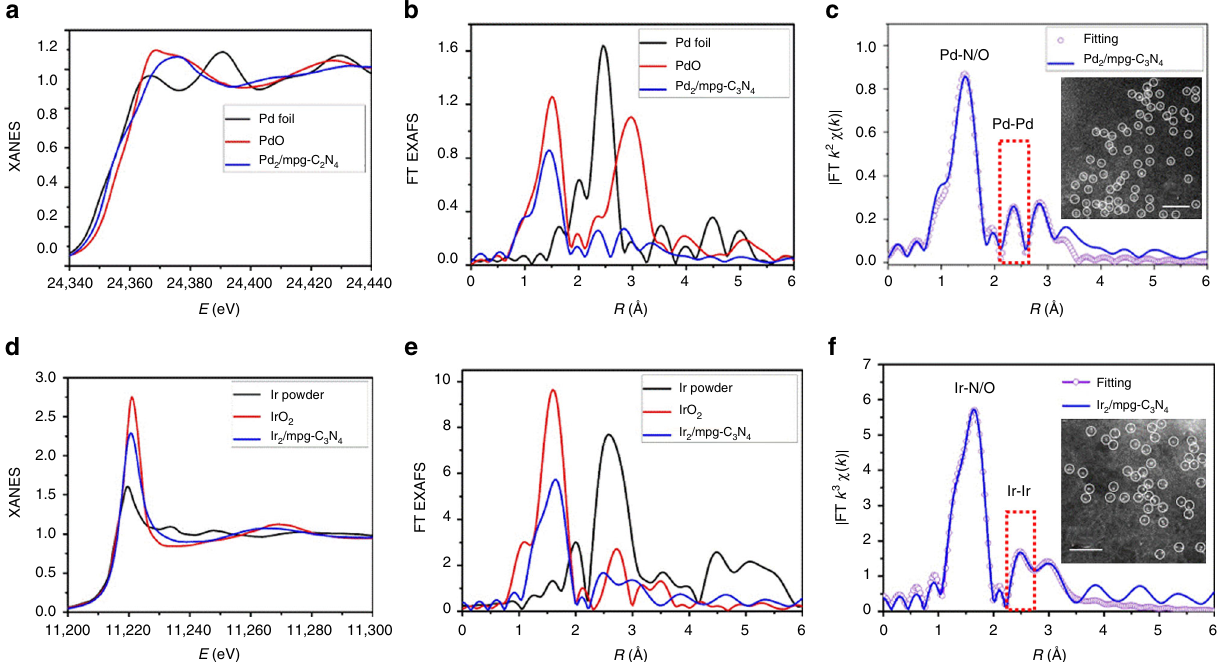
Fig. 4 Characterization of other TM 2 /mpg-C 3 N 4 clusters. a XANES spectra at the Pd k-edge of Pd 2 /mpg-C 3 N 4 , PdO, and Pd foil. b Fourier transform (FT) at the Pd k-edge of Pd 2 /mpg-C 3 N 4 , PdO, and Pd foil. c Corresponding fi ts of the EXAFS spectrum of Pd 2 /mpg-C 3 N 4 at R space. The inset of ( c ) is the AC HADDF-STEM of Pd 2 /mpg-C 3 N 4 , scale bar, 1 nm. d XANES spectra at the Ir L 3 -edge of Ir 2 /mpg-C 3 N 4 , IrO 2 , and Ir powder. e Fourier transform at the Ir L 3 - edge of Ir 2 /mpg-C 3 N 4 , IrO 2 , and Ir powder. f Corresponding fi ts of the EXAFS spectrum of Ir 2 /mpg-C 3 N 4 at R space. The inset of ( f ) is the AC HADDF- STEM of Ir 2 /mpg-C 3 N 4 , scale bar, 1